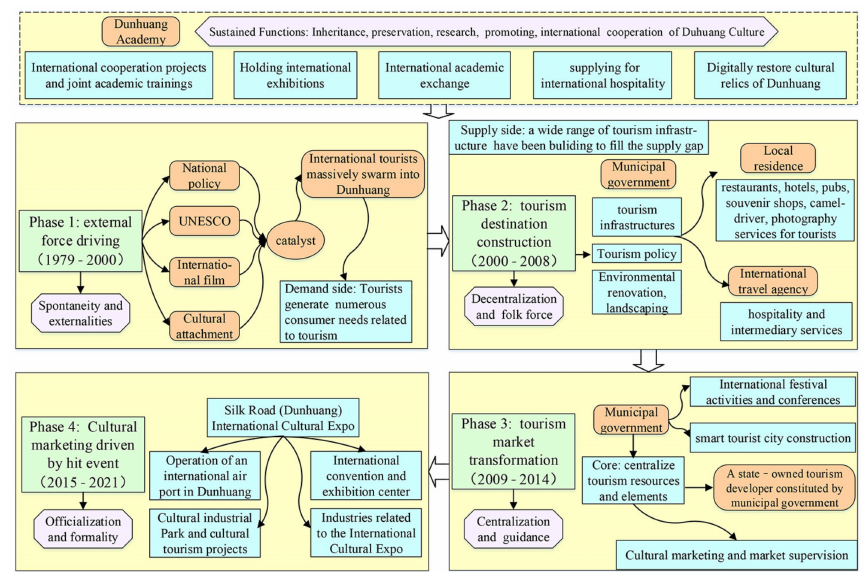
Figure 6. The globalization path and progress of